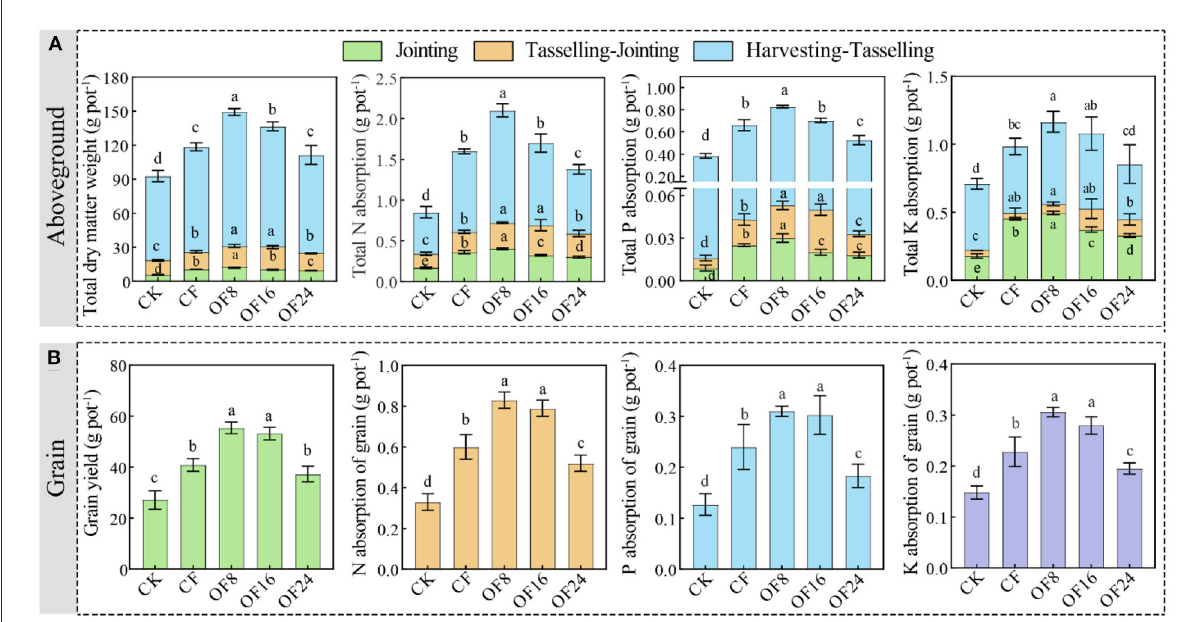
FIGURE1 Effects of different treatments on total dry matter, yield, and nutrient absorption of maize aboveground (A) and grain (B) . The error bars show the standard deviation of the mean of each treatment ( n = 3). Different lowercase letters represent significant differences at the level of p <